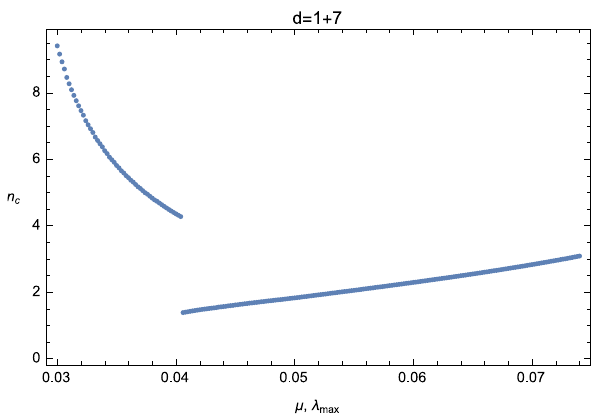
Figure 5. n c for (cid:22) and corresponding maximum value of (cid:21) allowed by causality for which phase min transition occurs. The discontinuity in n c at (cid:22) = 0 : 0406 is due to the jump in (cid:21) max from the helicity 2 curve to the curve (cid:22) c in (cid:12)gure 3. The lowest value of n c 2 (cid:21) max = 0 :